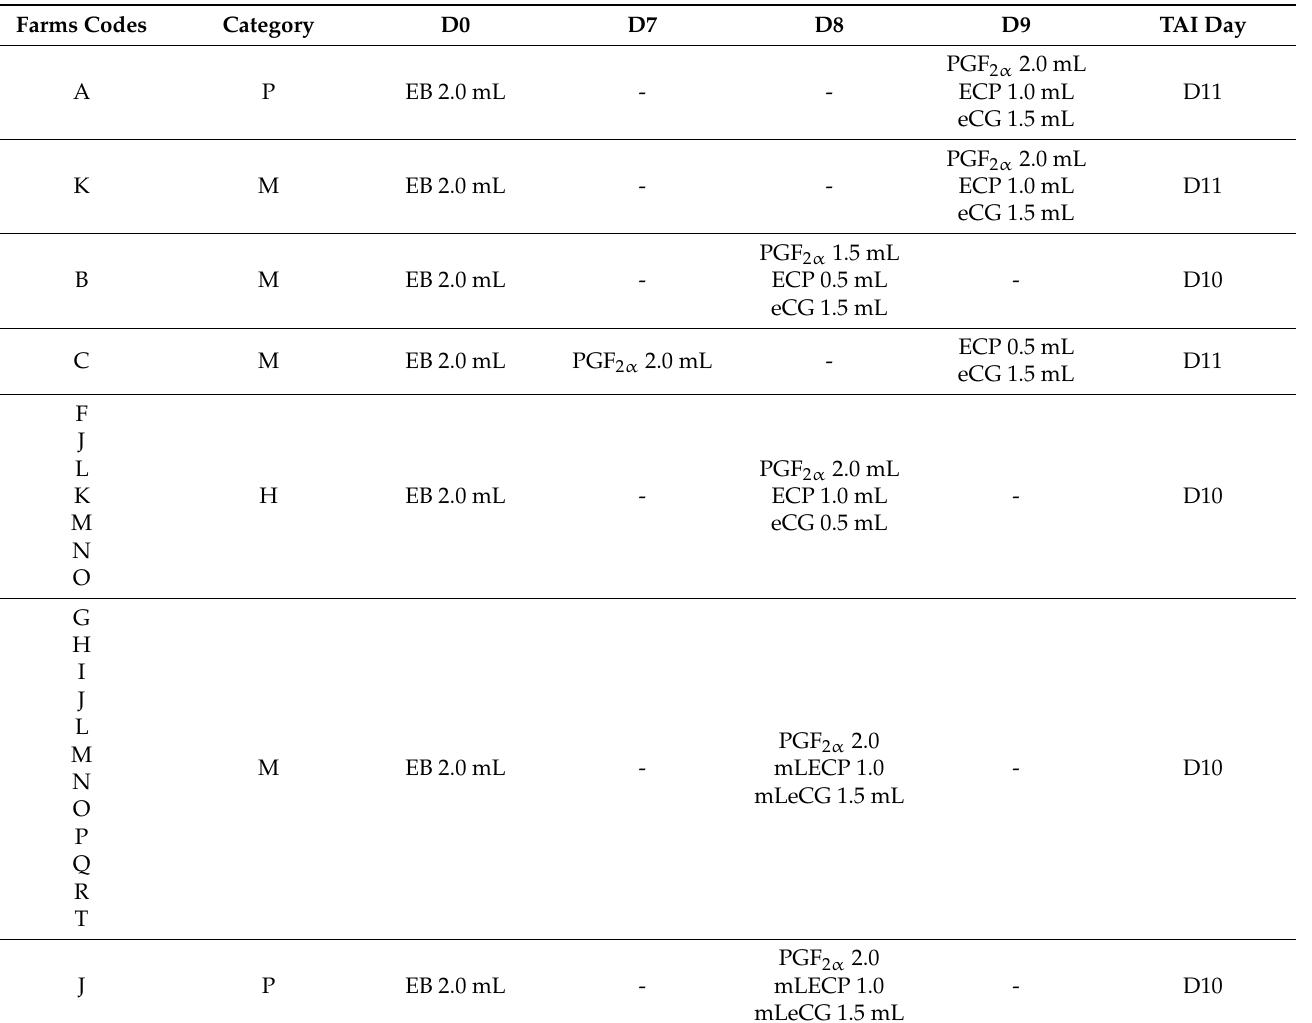
Table 1. The Estrus Synchronization Protocols adopted by the partner farm (in letter codes) depen- dently on the cows’ category (H = heifers, P = primiparous, or M = multiparous). Days of hormones administration (D0 = day zero, D7 = day seven, D8 = day eight, D9 = day nine) and TFAI day (day of the AI procedure (with or without the eGAL-1